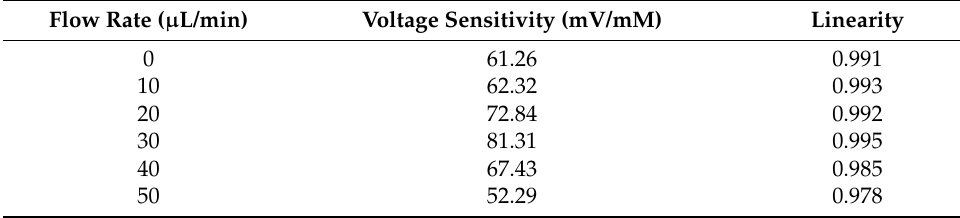
Figure 10. The sensing characteristics of EGFET for LA detection under the dynamic microfluidic measurement. ( a ) I DS –V REF conversion curve, ( b ) voltage sensitivity I DS = 100 µ A, ( c ) I DS –V DS transfer curve, and ( d ) current sensitivity. Table 1. The response voltages under different flow rates. Flow Rate ( µ L/min) Voltage Sensitivity